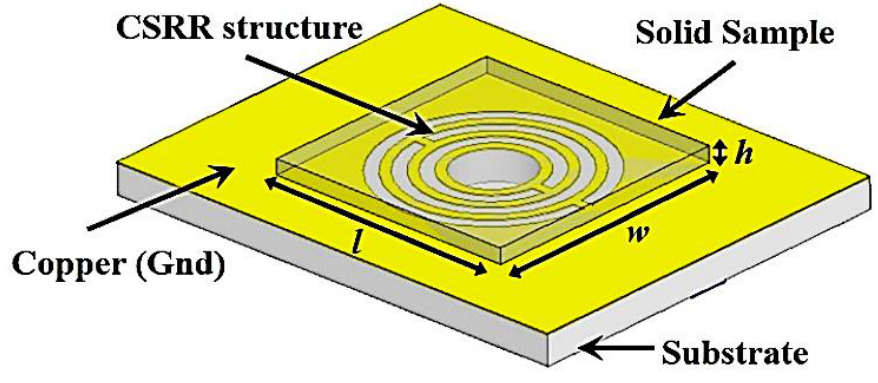
Figure 7. Curve-feed CSRR sensor with a solid overlay SUT.